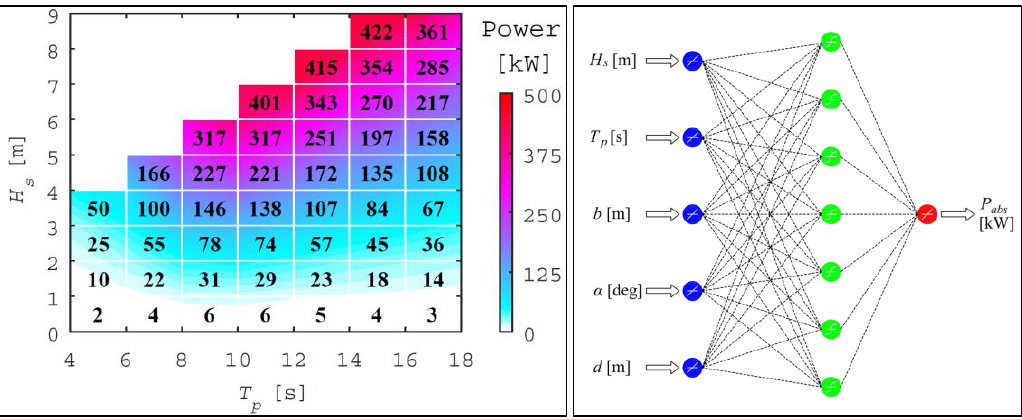
Figure 2. Absorbed power matrix of CECO for a power take-off (PTO) inclination of a = 45° and an operating water depth of d = 30 m ( left ) and an example of the artificial neural network (ANN) that is being trained to estimate CECO’s performance under site-specific wave conditions ( right